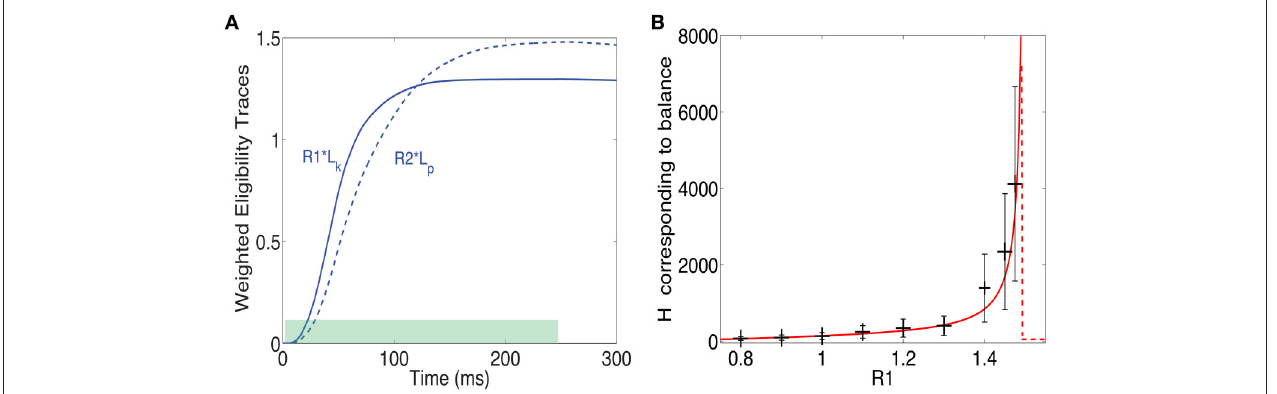
FIGURE 7 | Training with a step function reward. (A) A pattern can be rewarded throughout the time it is presented (green shaded area), and not just at one time point as above. In such a case at steady state the integral of the LTP eligibility trace times its associated reward magnitude (solid line) is equal to the LTD eligibility trace times its associated reward (dashed line). (B) H at steady state vs. R p / R d when T d max / T p max = 1.5. The solid red line represents the analytical solution and the gray bars represent the mean and standard deviation of simulations. The variability is over different synapses and time